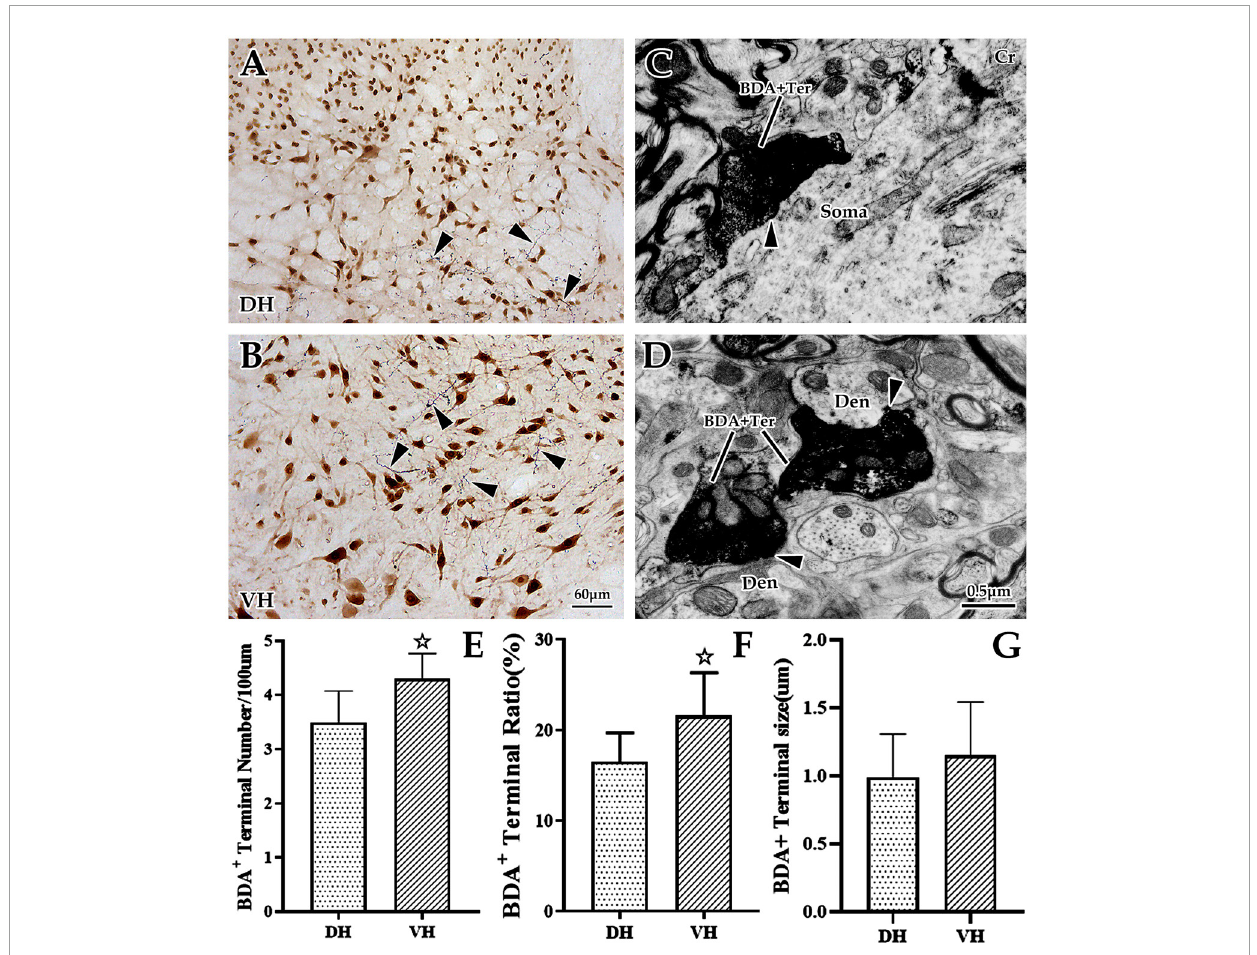
FIGURE2 The distribution and ultrastructural characteristics of cortical glutamatergic terminals in the cervical spinal gray matter. (A,B) Show cortical glutamatergic terminals labeled by biotinylated dextran amine (BDA) injection (blue) and spinal neurons immunolabeled by NeuN (brown). BDA+ fibers are observed at the dorsal horn (DH) (A) and ventral horn (VH) (B) , and these beaded BDA+ fibers had abundant branches ( (cid:77) ). Electron microscope (EM) showed that BDA+ terminals were oval or circular, with a large number of medium-sized vesicles. These positive terminals made asymmetric (excitatory) synaptic connections either with somas (C) or with dendrites (D) . (A,B) Show the same magnification with a scale bar = 60 µ m. (C,D) Show the same magnification, and the scale bar is shown in the right lower corner of (D) . Histogram (E) shows the density of BDA+ fibers in the DH and VH for immuno-light microscopy (LM) experiments. Histograms (F,G) show the labeling rate and size of BDA+ terminals in the DH and VH for immuno-EM experiments, respectively. In the above panels, the DH and VH were short of the dorsal horn and the ventral horn. Den, dendrite; Ter, terminal; Soma, cell body. P < 0.05, compared between the DH and VH.